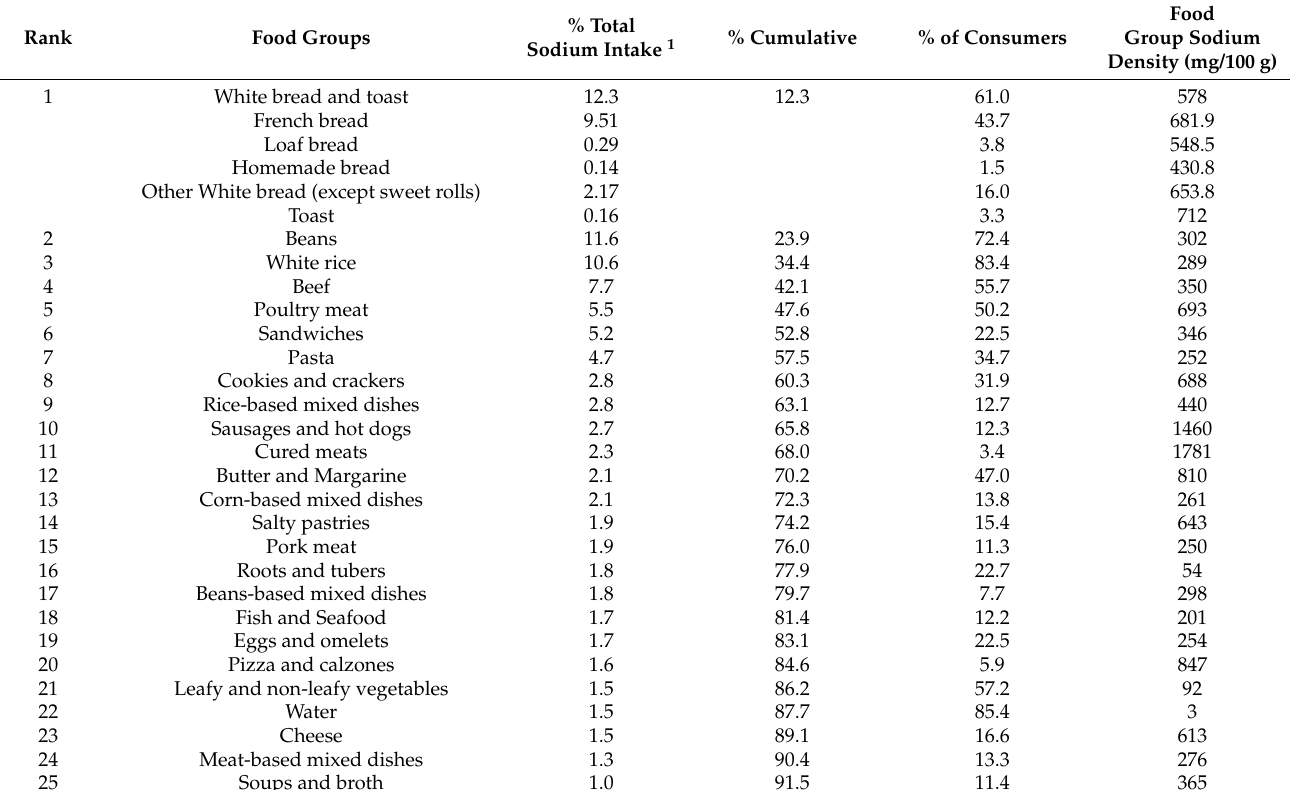
Table 2. Description of the food groups contributing to >1% of total sodium intake, prevalence of consumers, and food group sodium density among Brazilian adults. Household Brazilian Budget Survey,